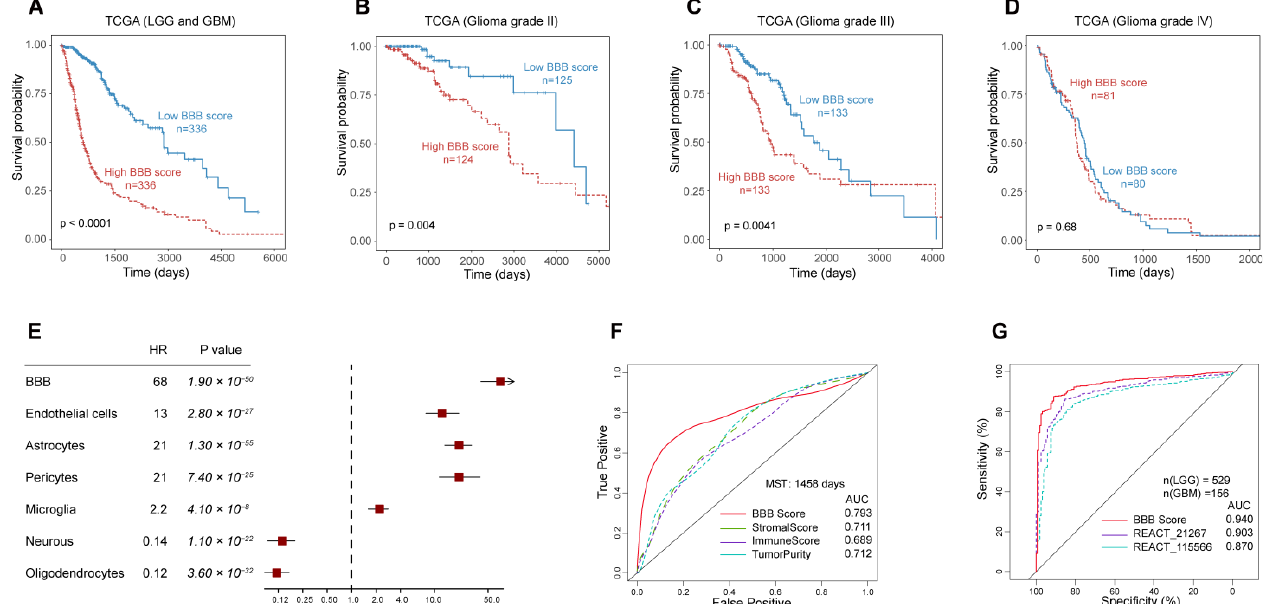
Figure 4. The prognostic value of the BBB score in the TCGA cohort ( A ) and subgroups defined by WHO grade ( B – D ). The association between GSVA scores of all stromal cells in the glioma TME with clinical outcome ( E ) and BBB score had the most robust predictive and discriminative power for median survival time (F) and WHO grade (G) of TCGA glioma patients.